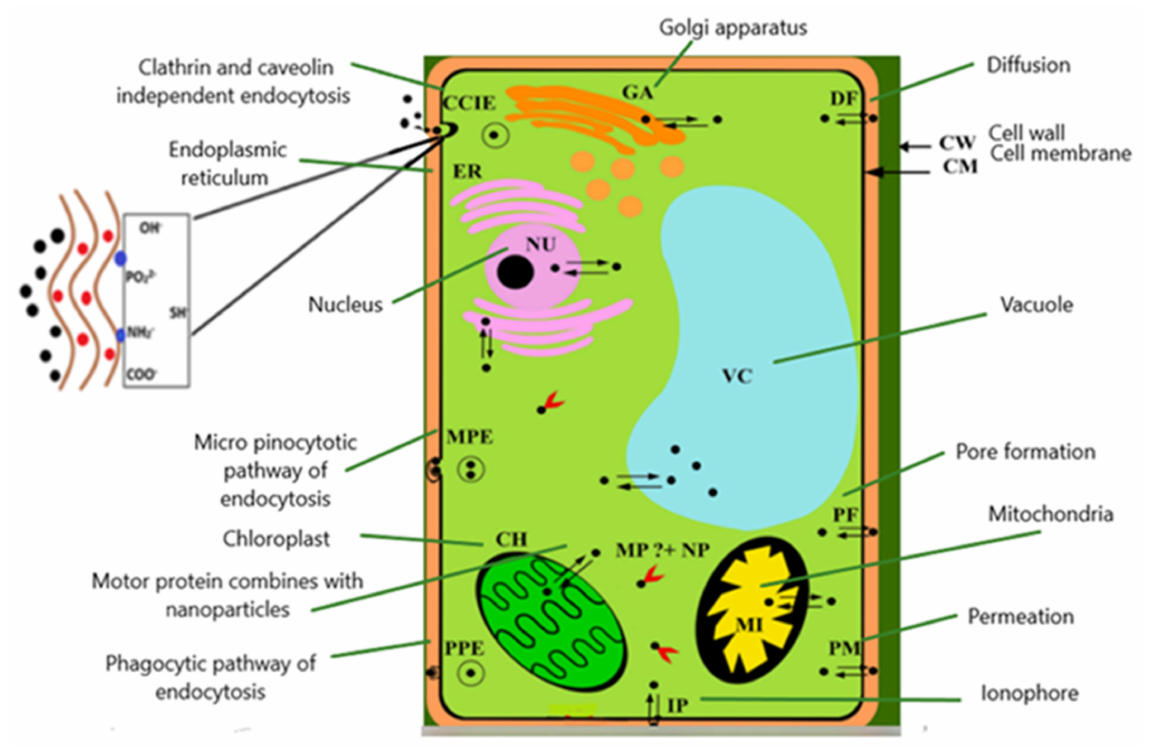
Figure 3. Schematic illustration of potential pathways of intracellular NP uptake in the algal cell. NPs can accumulate in a gap between the cell wall and the cell membrane in algal cells. Metal ions enter the cells through ion channels and carrier proteins after NPs are dispersed in the external media. The transfer of NPs is then aided by transport proteins that move NPs from one location to another [15]. Exopolysaccharides and glycoproteins, which are secreted by a variety of algae and cyanobacteria, may aid in the adsorption of uncharged or neutral NPs on the surfaces